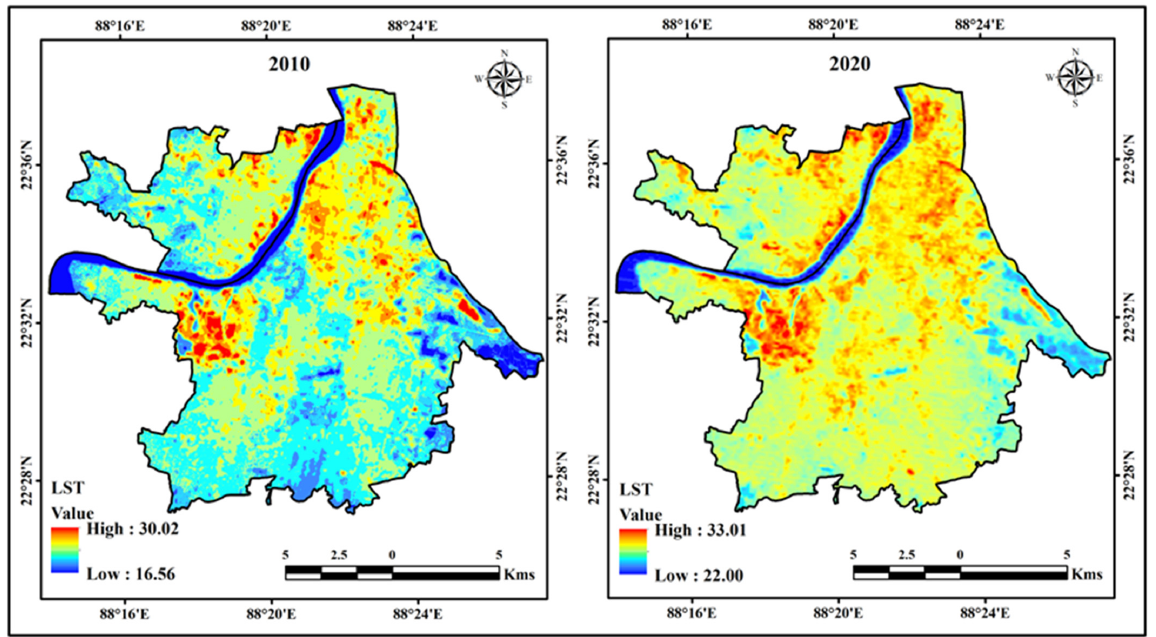
Figure 7. The LST variation over the years 2010 and 2020 for West Bengal (Kolkata and Howrah).